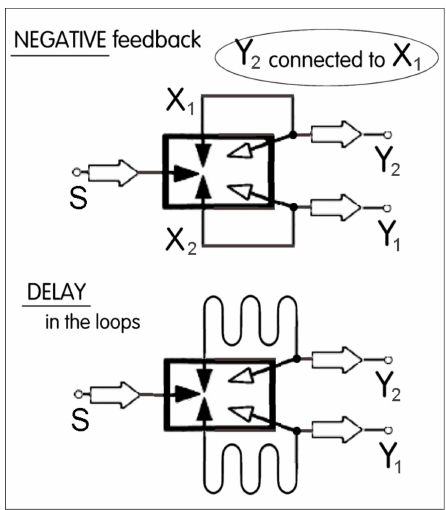
Figure 14. The two basic properties of the oscillator feedback in Figures 11 and 12 are ( a ) the inversion—needed for the negative character of the feedback—and ( b ) a suitable delay time. Top: the inversion of the signal is through mutual connections of Y 1 with X 2 . Bottom: the simplest time delay is obtained with signal propagation through large loop channel